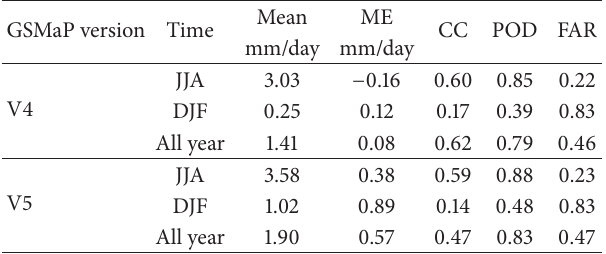
Table 3: Validation statistics comparing the performances of GSMaP rainfall estimates over the Qinghai-Tibet Plateau (Region